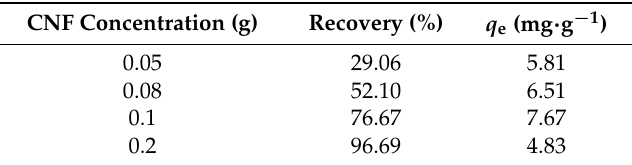
Table 7. Effect CNF concentration. Experimental conditions: CNF = variable, V = 100 mL of [Cu 2+ ] =